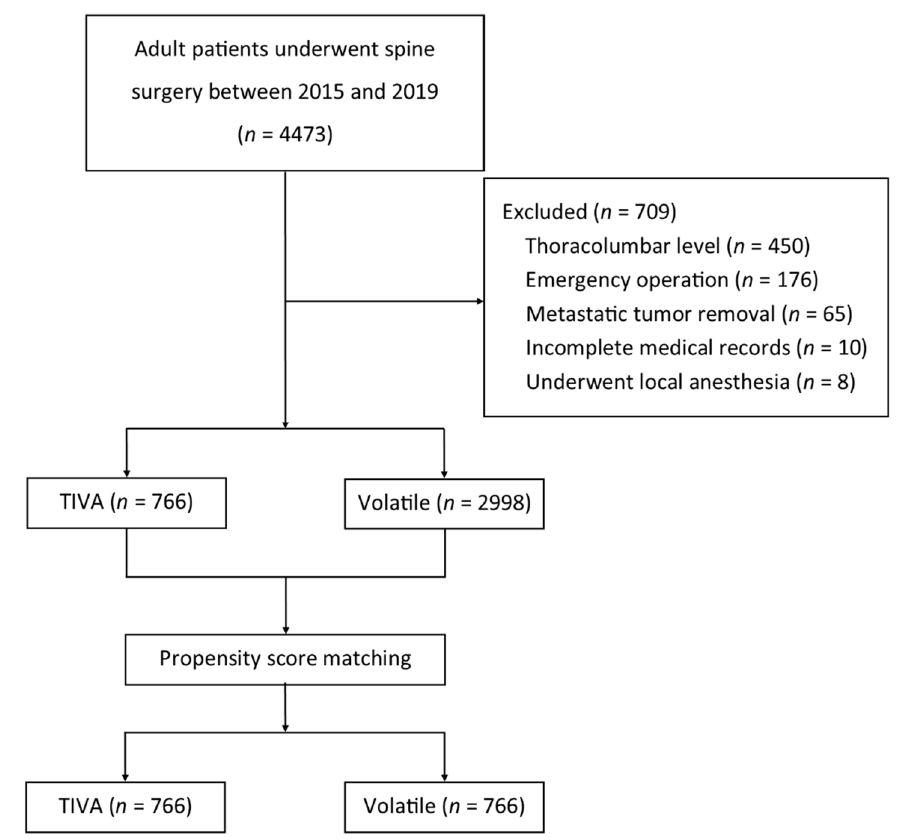
Figure 1. Flow diagram.